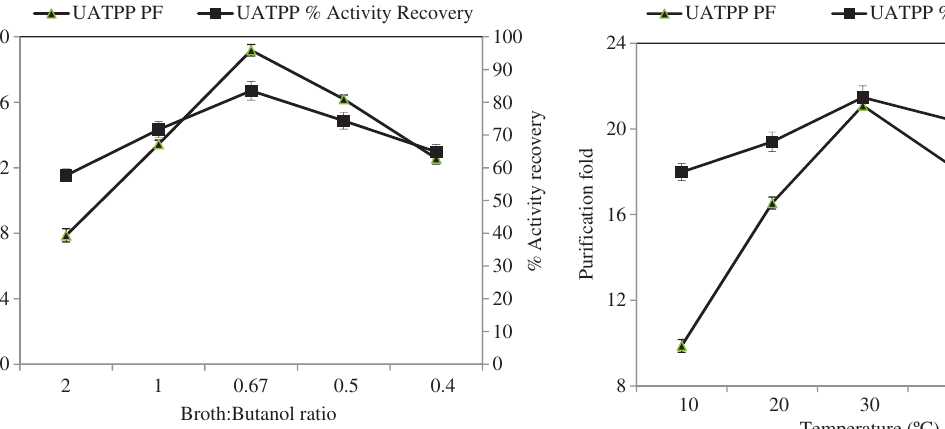
Figure 3: Effect of broth to t-butanol ratio on ultrasound assisted three phase partitioning (UATPP) of peroxidase.